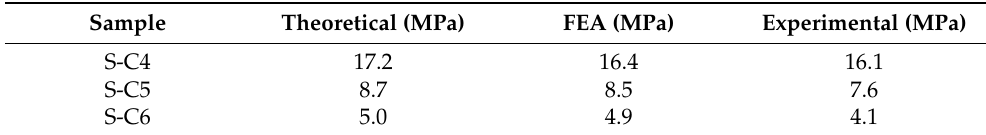
Table 2. Comparison of in–plane equivalent elastic modulus of the SLM–fabricated active SMA honeycomb arrays among theoretical, FEA, and experimental